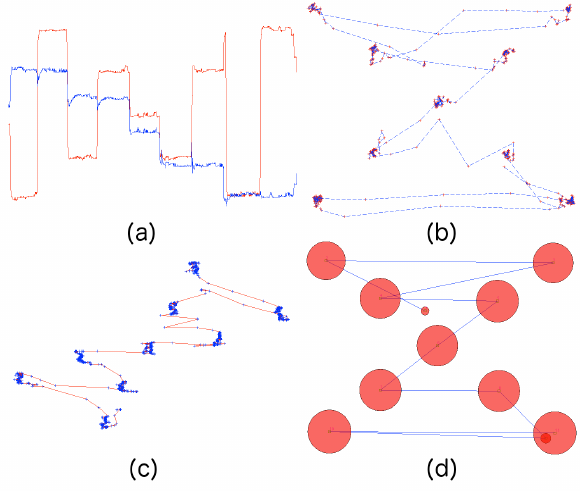
Different types of supported visualizations: (a) Horizontal (red) and vertical (blue) coordinate along time dimension. (b) Visu- alization of raw data (red) distribution. The blue dashed line corresponds to the trace of visual search. (c) Space-time-cube visualization. Blue points correspond to raw data while the visual trace is presented with red. (d) Scanpath visualization. The circles correspond to relative durations of fixations while saccades are presented with